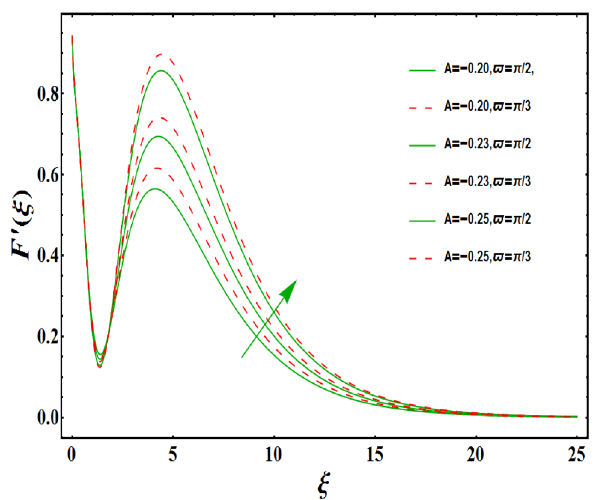
Figure 9. Variation of A < 0 on F ′ (ξ) for both with and without inclanation.